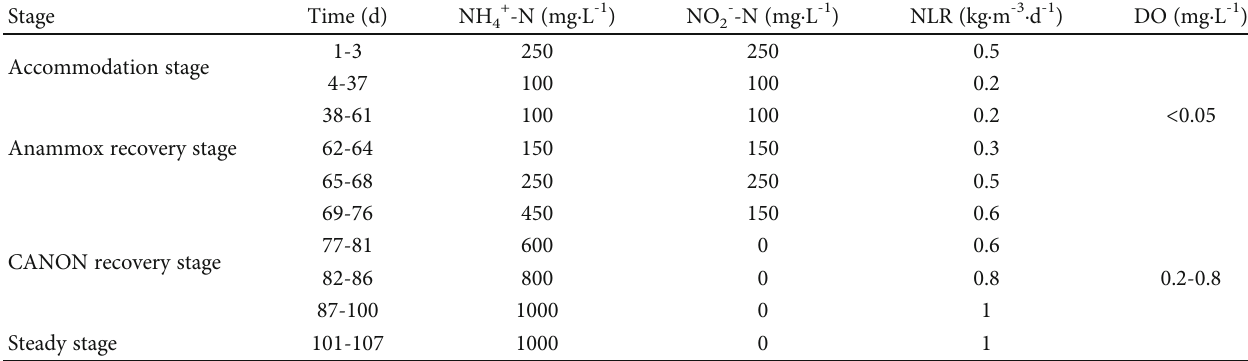
Table 1: Operational conditions of the CANON process after the alkaline